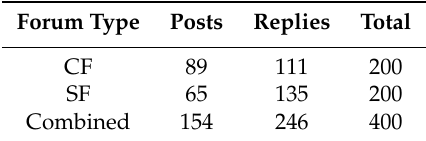
Table 2. Message type by forum type.